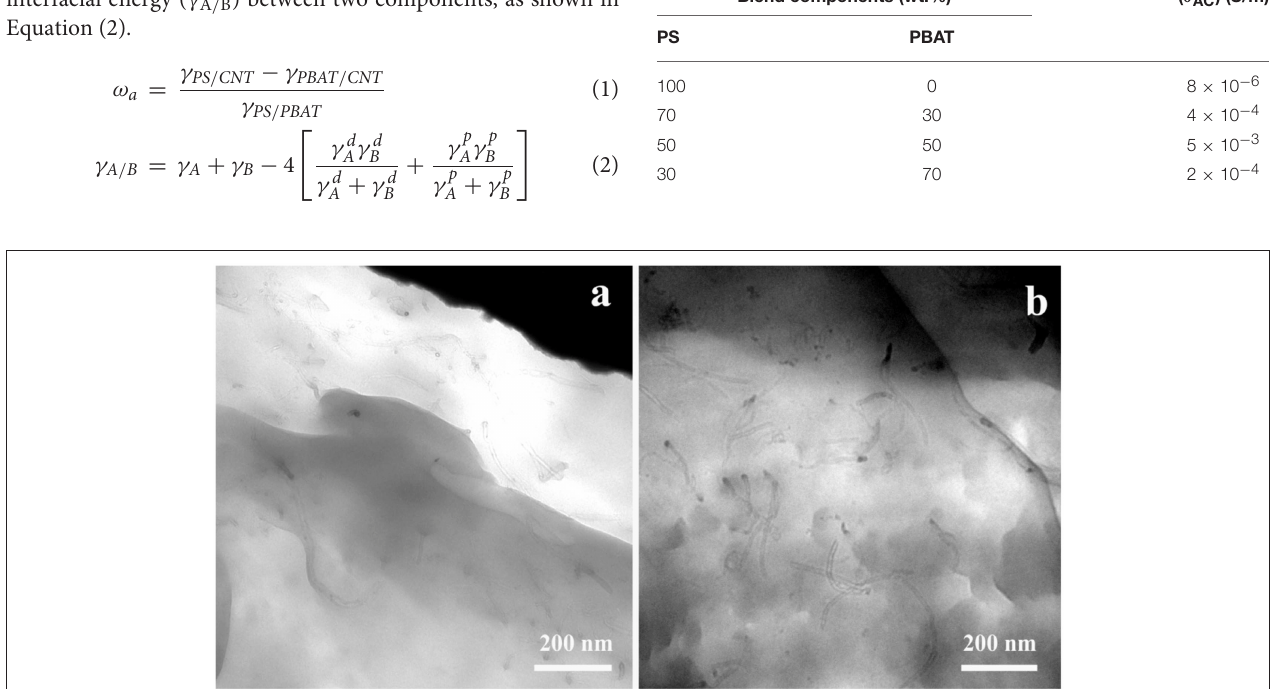
FIGURE 7 | TEM micrographs of PS/PBAT composites containing 0.66% of (a) pCNT and (b) IL-CNT, and molded at 200 ◦ C.